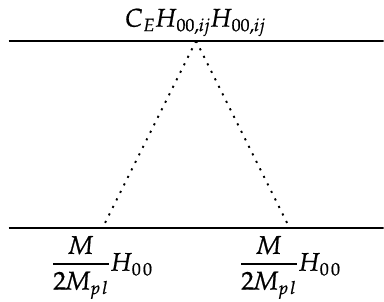
Figure 1 . Leading Order E